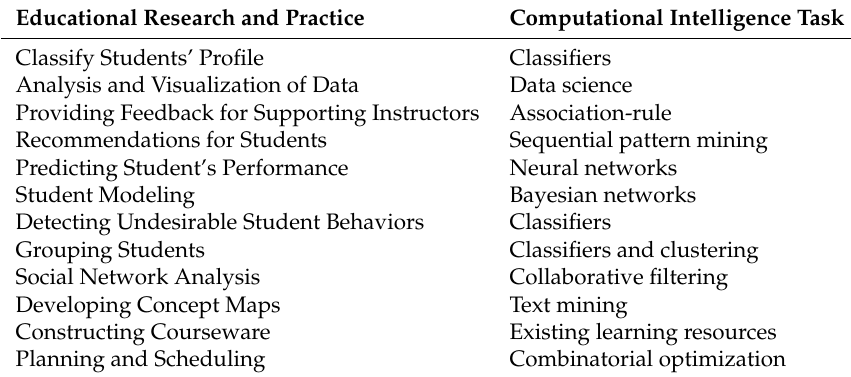
Table 4. Educational research and